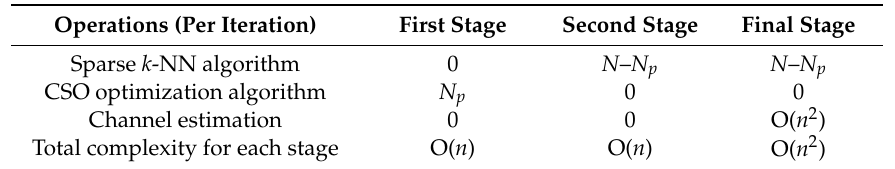
Table 3. Complexity analysis of the proposed system.